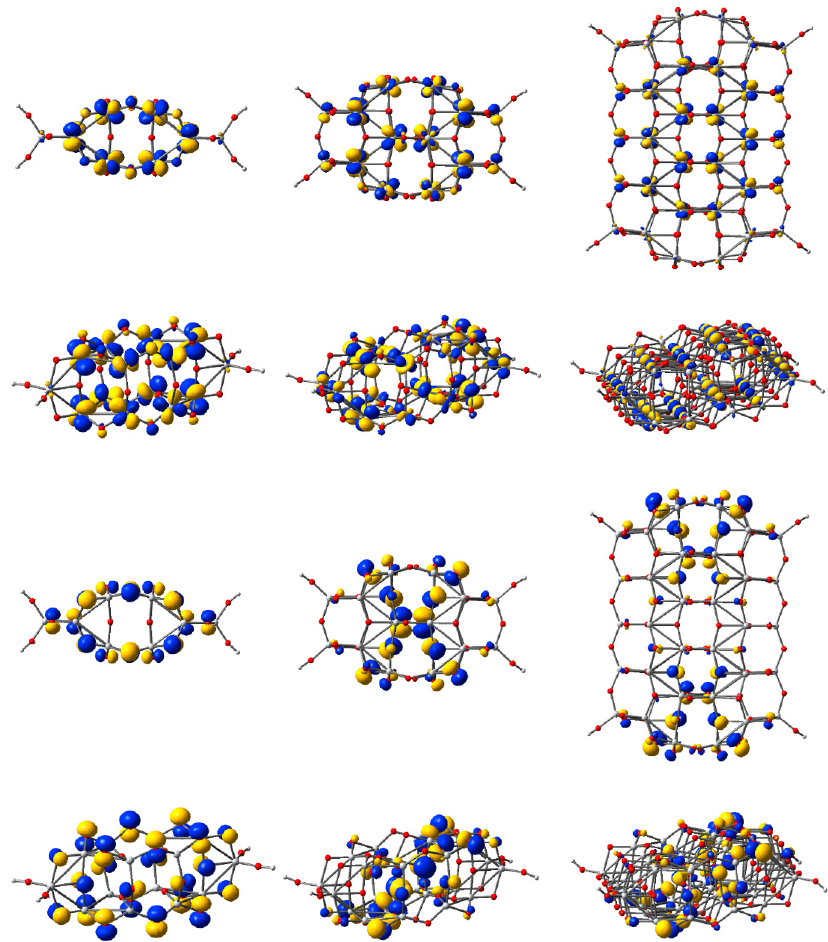
Figure 7. Isodensity surfaces (0.03 e/bohr 3 ) of the key molecular orbitals of Ti n O 2 n +2 H 4 clusters ( n = 14, 24, 54, from left to right, respectively), calculated by DFT at the B3LYP/LANL2DZ level in water solvent. The first two rows display the top and a perspective view of the LUMOs, whereas the bottom two rows show the top and a perspective view of the HOMOs. Atom colors: Ti, grey; O, red; and H, light grey.